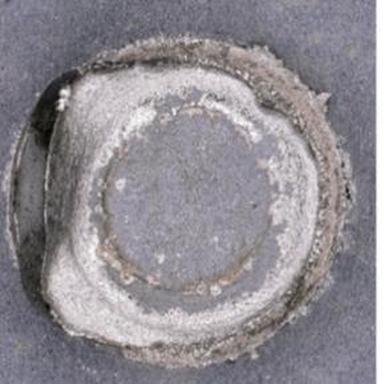
Post-failure macro-images of Usibor® 1500-AS and Ductibor® 1000-AS spot welds under shear and normal loading.